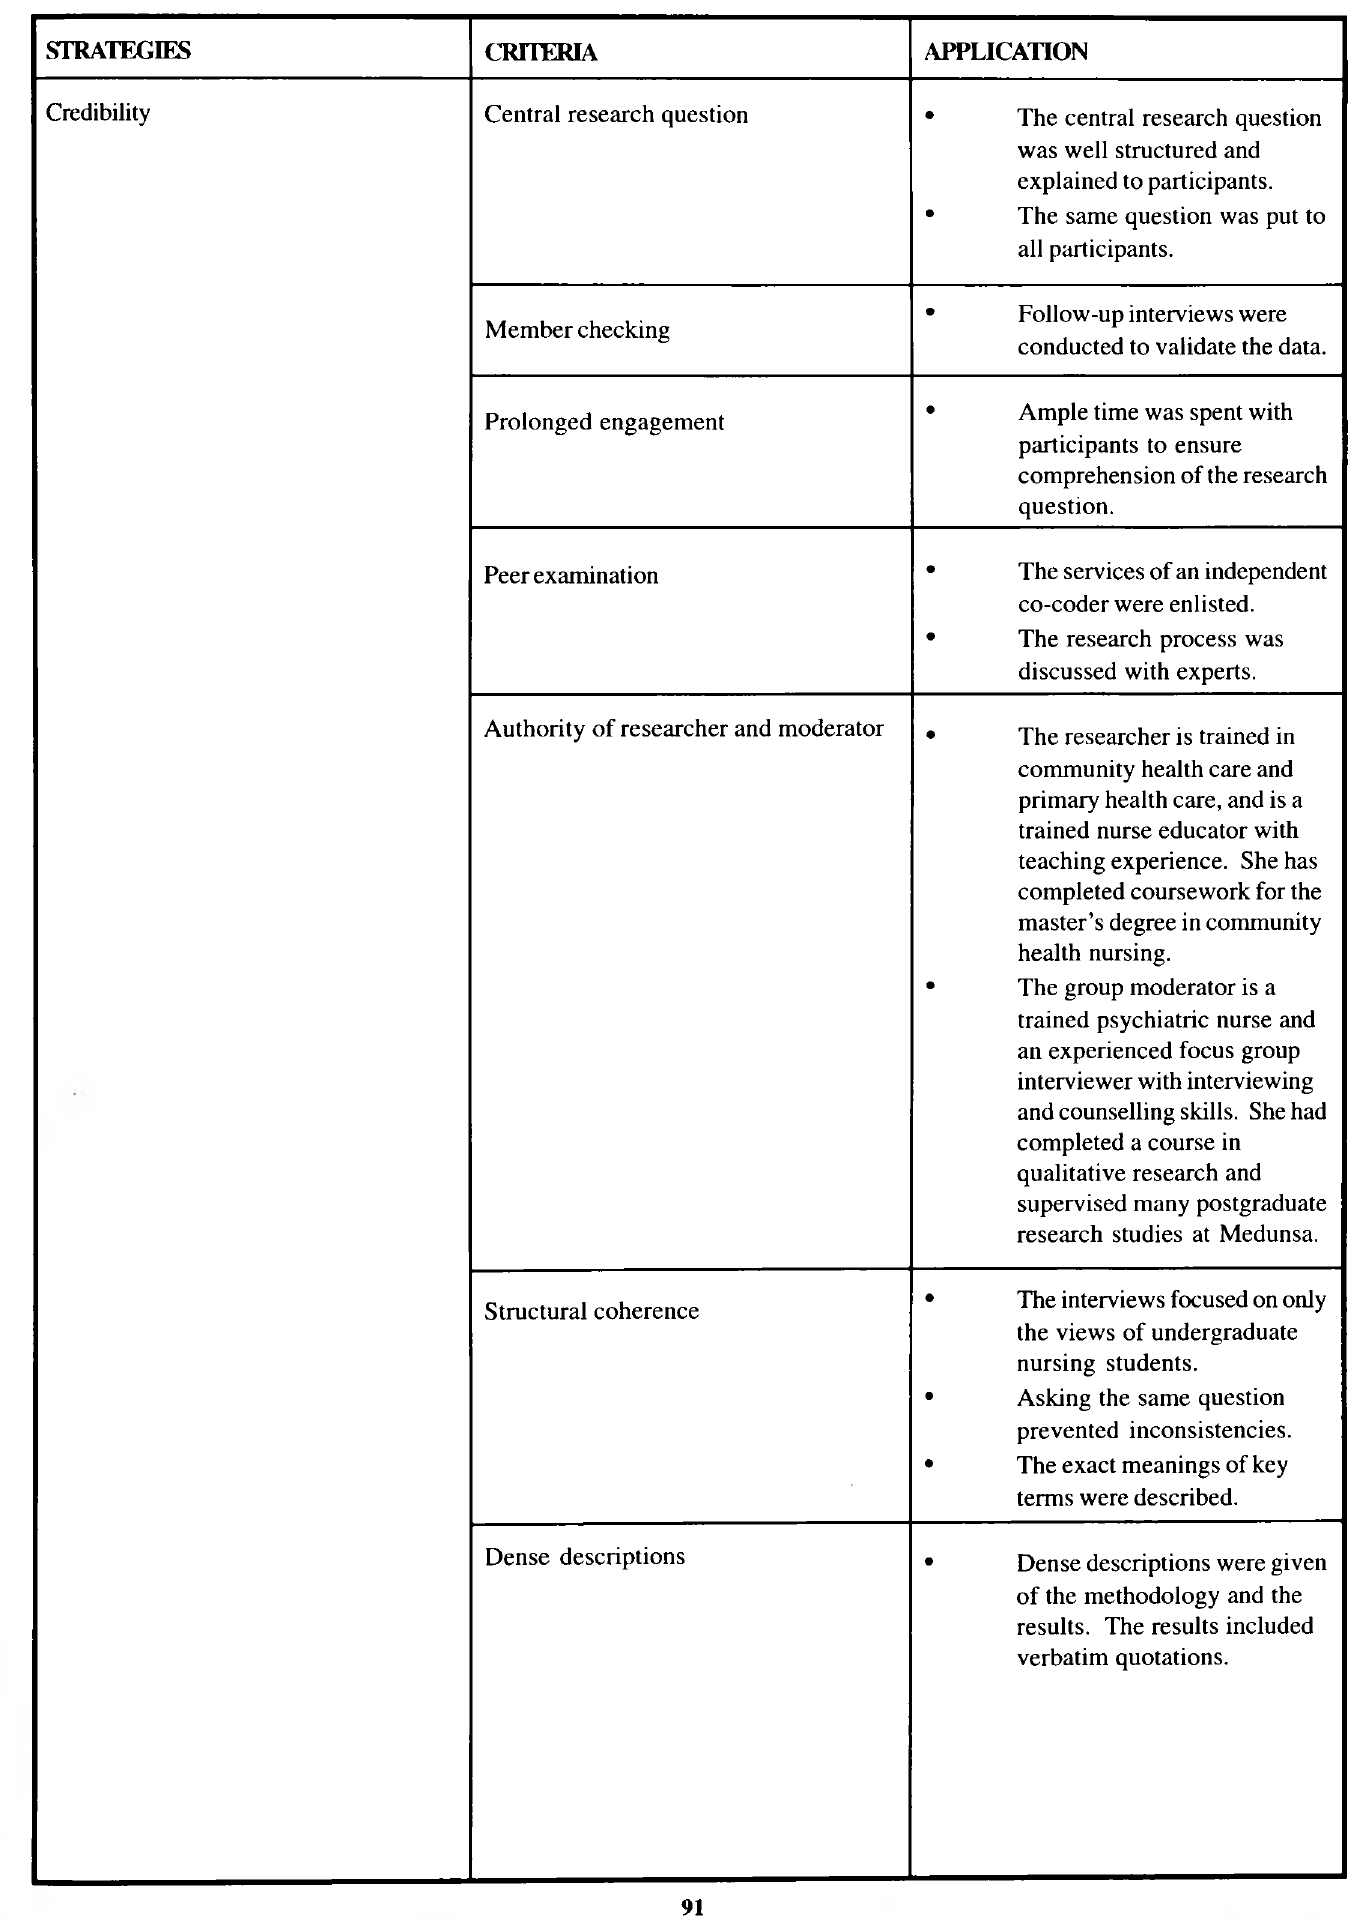
Table 1: Strategies to establish trustworthiness